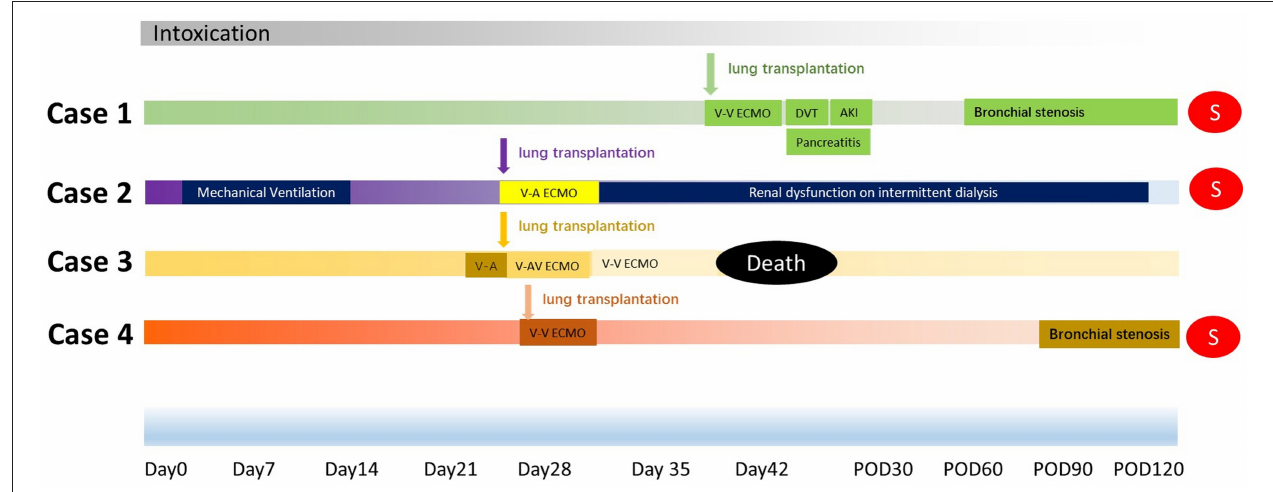
FIGURE 2 | Illustration of clinical course and perioperative events in Case 1–4. Pre-lung transplantation and intraoperative mechanical ventilation support, ECMO support modes and duration were illustrated. Post-lung transplantation events were labeled with outcome up to the follow-up date. S, survival; DVT, deep vein thrombosis; AKI, acute kidney injury; POD, post-operation day.